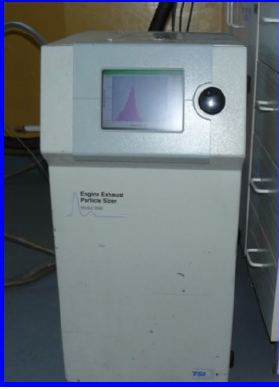
Figure 5. Engine Exhaust Particle Sizer (EEPS) 3090.